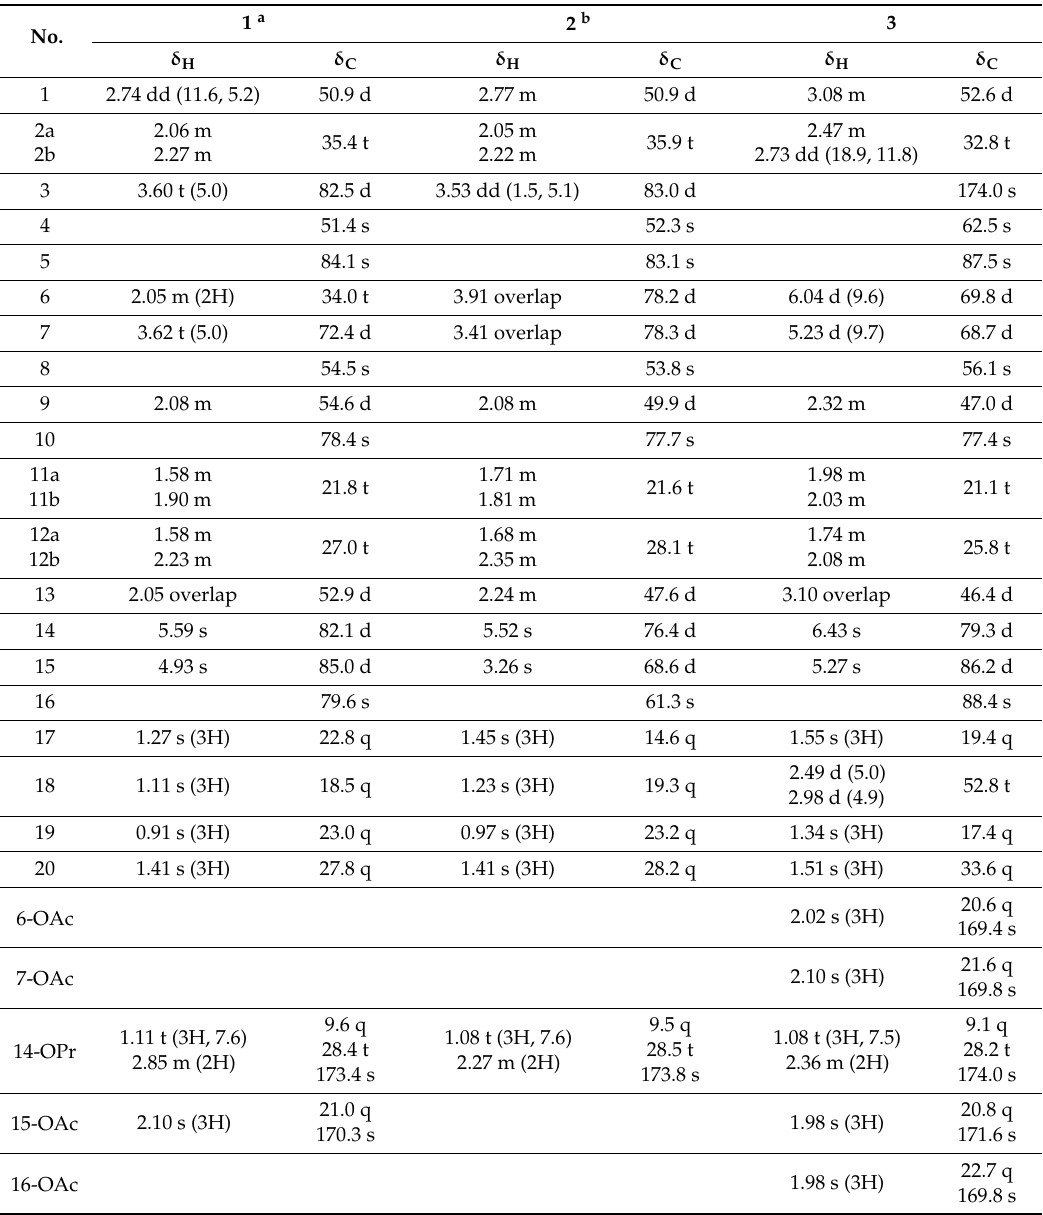
Table 1. 1 H- (400 MHz) and 13 C- (100 MHz) NMR spectroscopic data of compounds 1 – 3 in acetone- d 6 ( δ (ppm), J